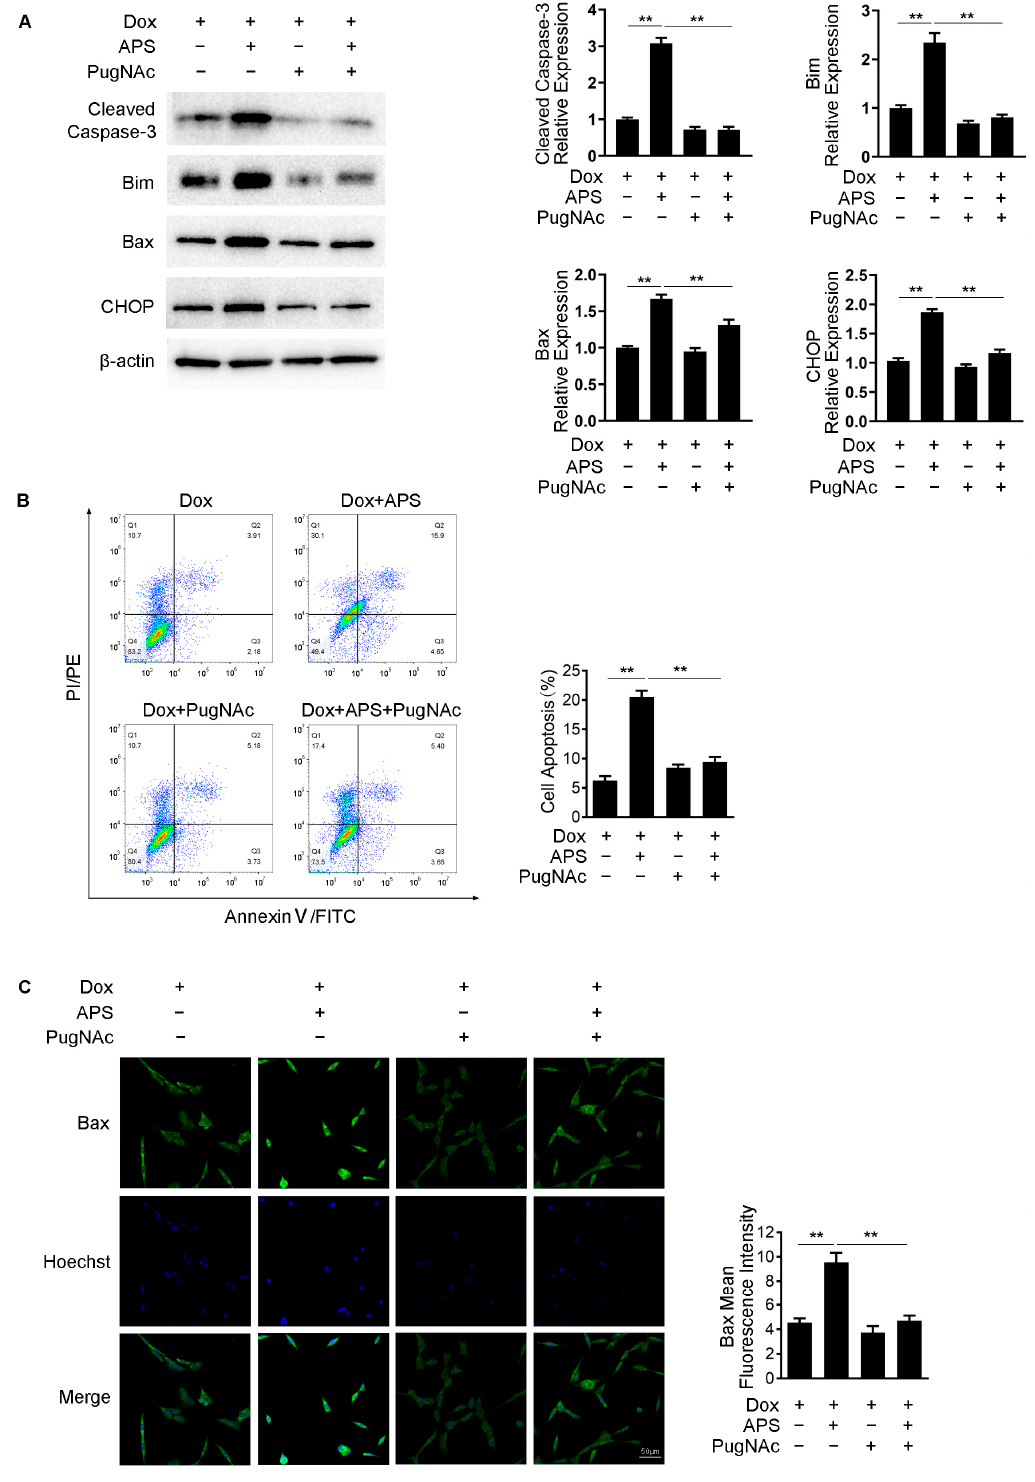
Figure 5. APS promotes Dox-induced apoptosis by decreasing intracellular O-GlcNAc levels. Under the treatment of 1 µ M Dox, Hep3B cells were treated with or without 50 mg/L APS and in the absence or presence 10 μ M PugNAc. Then, cells were subjected to ( A ) Western blot analysis for Cleaved Caspase-3, Bim, Bax and CHOP, ( B ) flow cytometry assay for cell apoptosis and ( C ) immunofluorescence for Bax. Images presented are representative of each group. Mean fluorescence intensity was measured using IPP software. Scale bar, 50 μ m. Five random visual fields were measured for each sample. Data are expressed as mean ± SEM from three independent experiments. **, p <